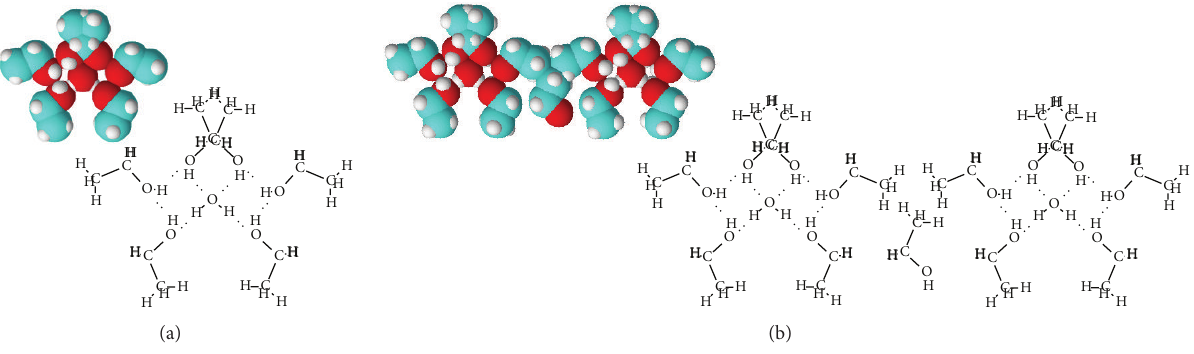
Figure 4: (a) Molecular structure of ethanol of 95.1%v. (b) Molecular structure of ethanol of